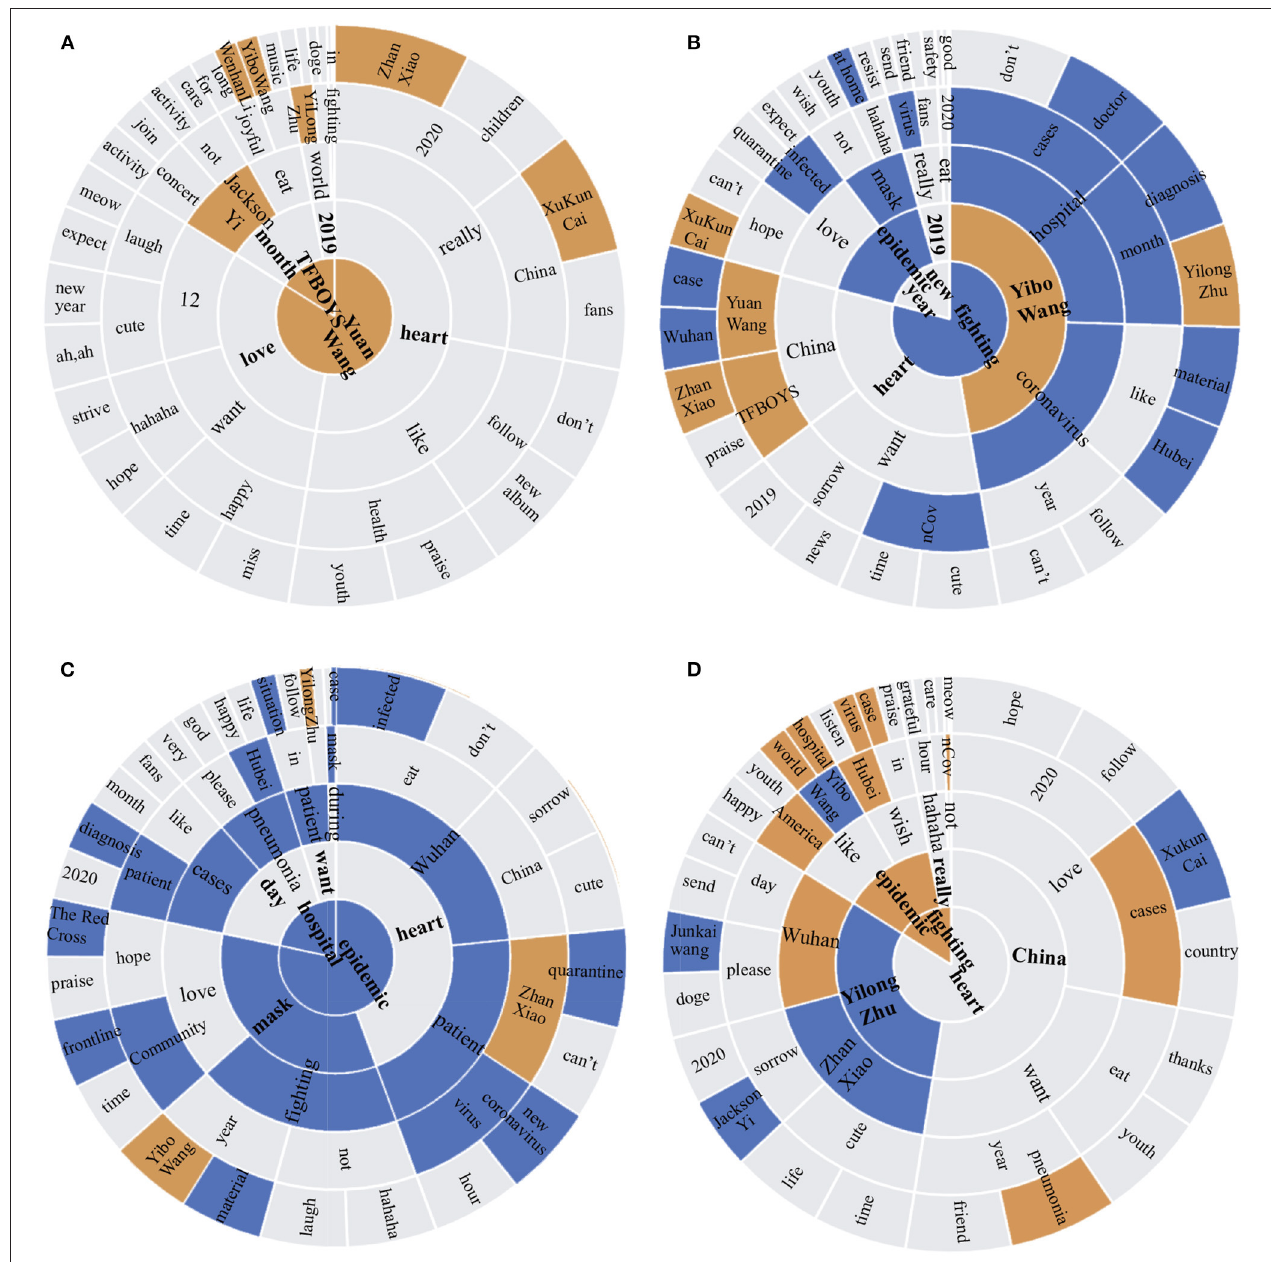
FIGURE 2 | Sunburst plots of Weibo content in four stages: (A) Before the outbreak; (B) Initial stage; (C) Severe stage; (D) Recovery stage. The closer a word is to the center of the circle, the higher the frequency of its presence. Moreover, three different topics are distinguished by color, including blue for the epidemic, brown for stars, and gray for social chatter. The non-translated plots are shown in Supplementary Figure 1 .